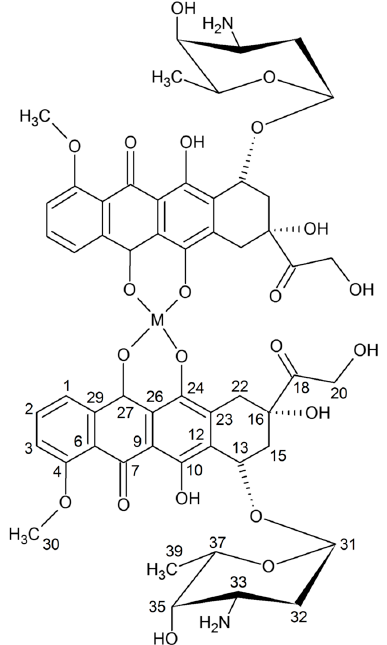
Figure 5. Proposal structure of complex metal-DOX.